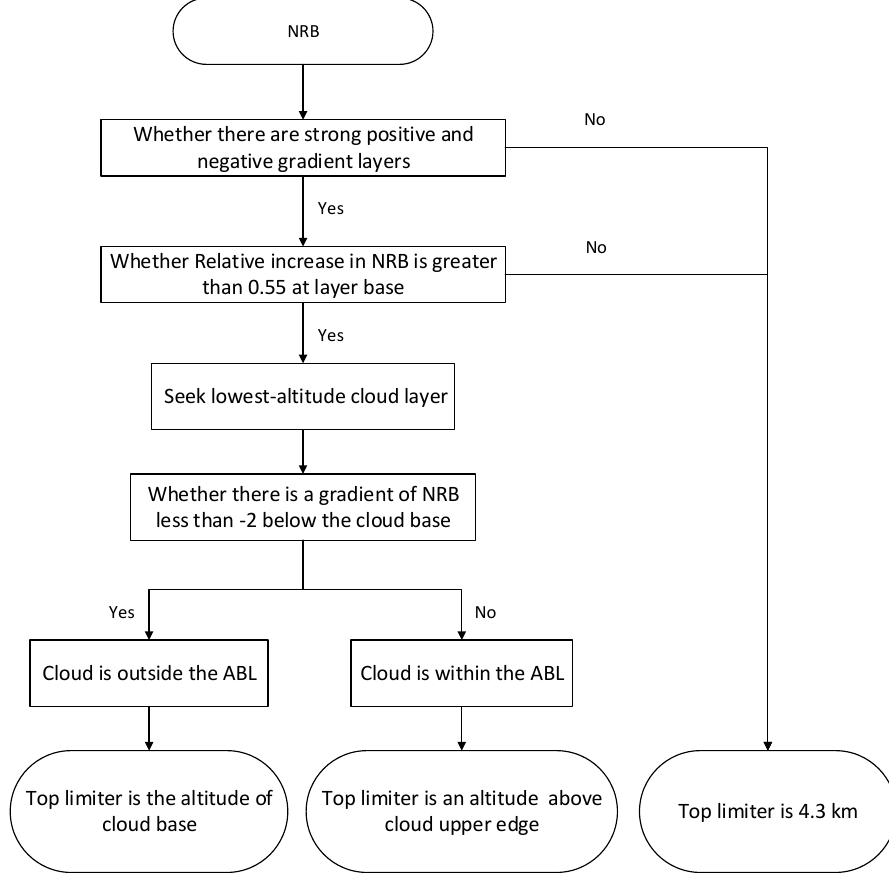
Figure 3. Major steps for determining the top limiter to eliminate the cloud effect on atmosphere boundary layer height (ABLH) retrieval in the new technique.